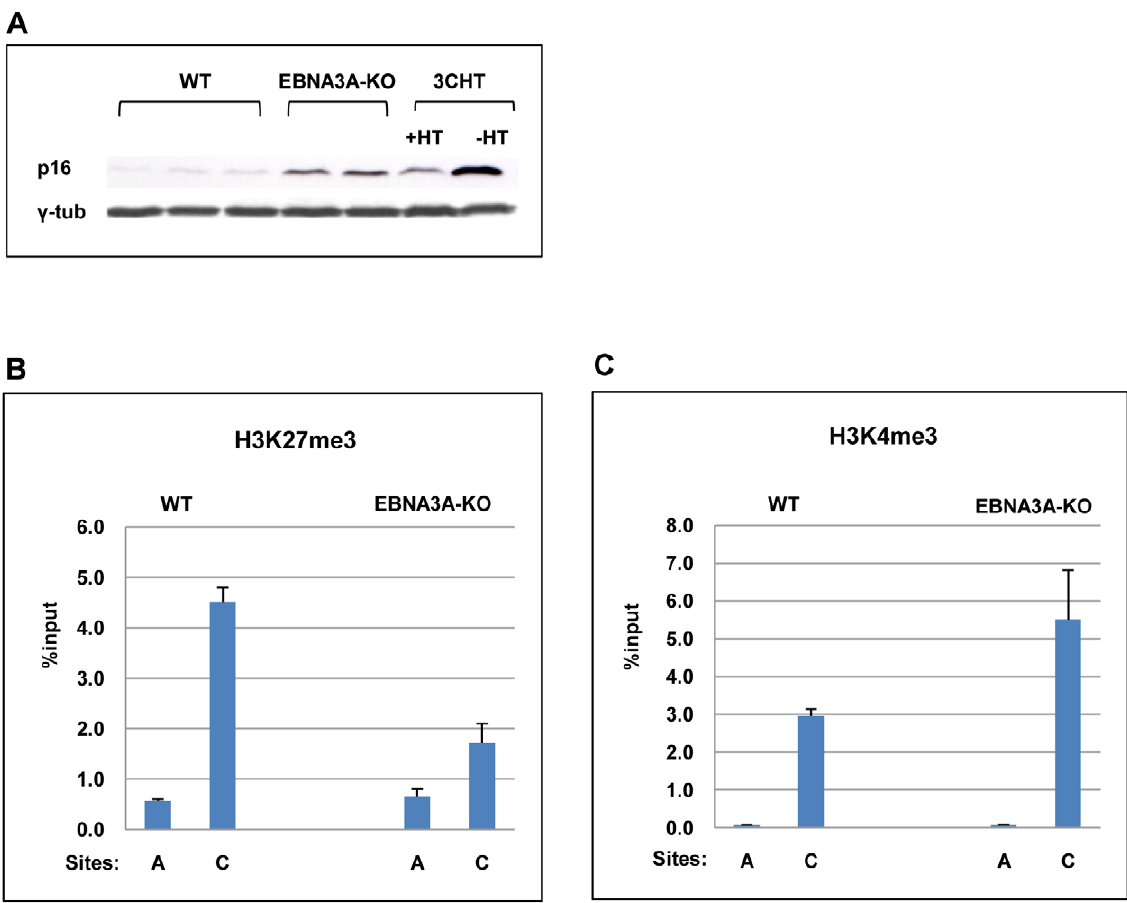
Figure 7. EBNA3A contributes to the regulation of p16 INK4A . ( A ) Western blot analysis of three LCLs established with virus derived from B95.8- EBV BAC (WT) and two established with EBNA3A-KO recombinants. The steady state levels of p16 INK4A (p16) are elevated in the EBNA3A-KO cells relative to the WT-EBV infected cells. It should be noted that similar results were reported using a larger panel of EBNA3A-KO LCLs [8]. An LCL 3CHT (3CHT) with ( + ) or without (-) HT is shown for comparison. ( B ) & ( C ) ChIP analysis of H3K27me3 and H3K4me3 distribution on exon 1 (site C) and site A in the p16 INK4A -ARF locus from an EBNA3A-KO LCL (3AKO) and a WT-EBV LCL (WT).